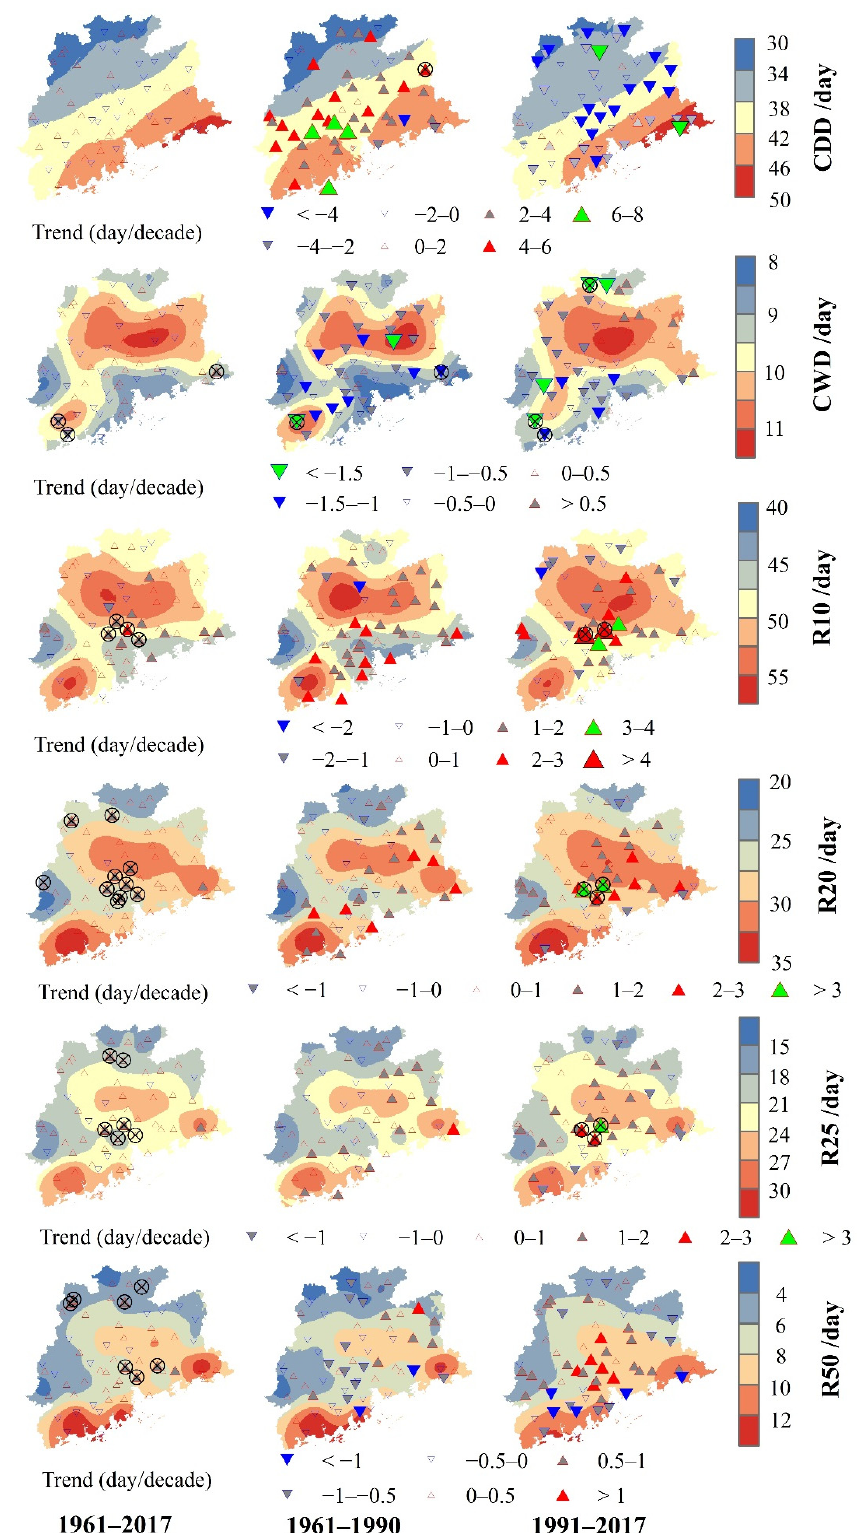
Figure 4. Spatial patterns of extreme precipitation indices and their linear trends over the PRD during 1961–2017, 1961–1990 and 1991–2017, respectively. Black crossings with circles denote a significant trend at the 95% confidence